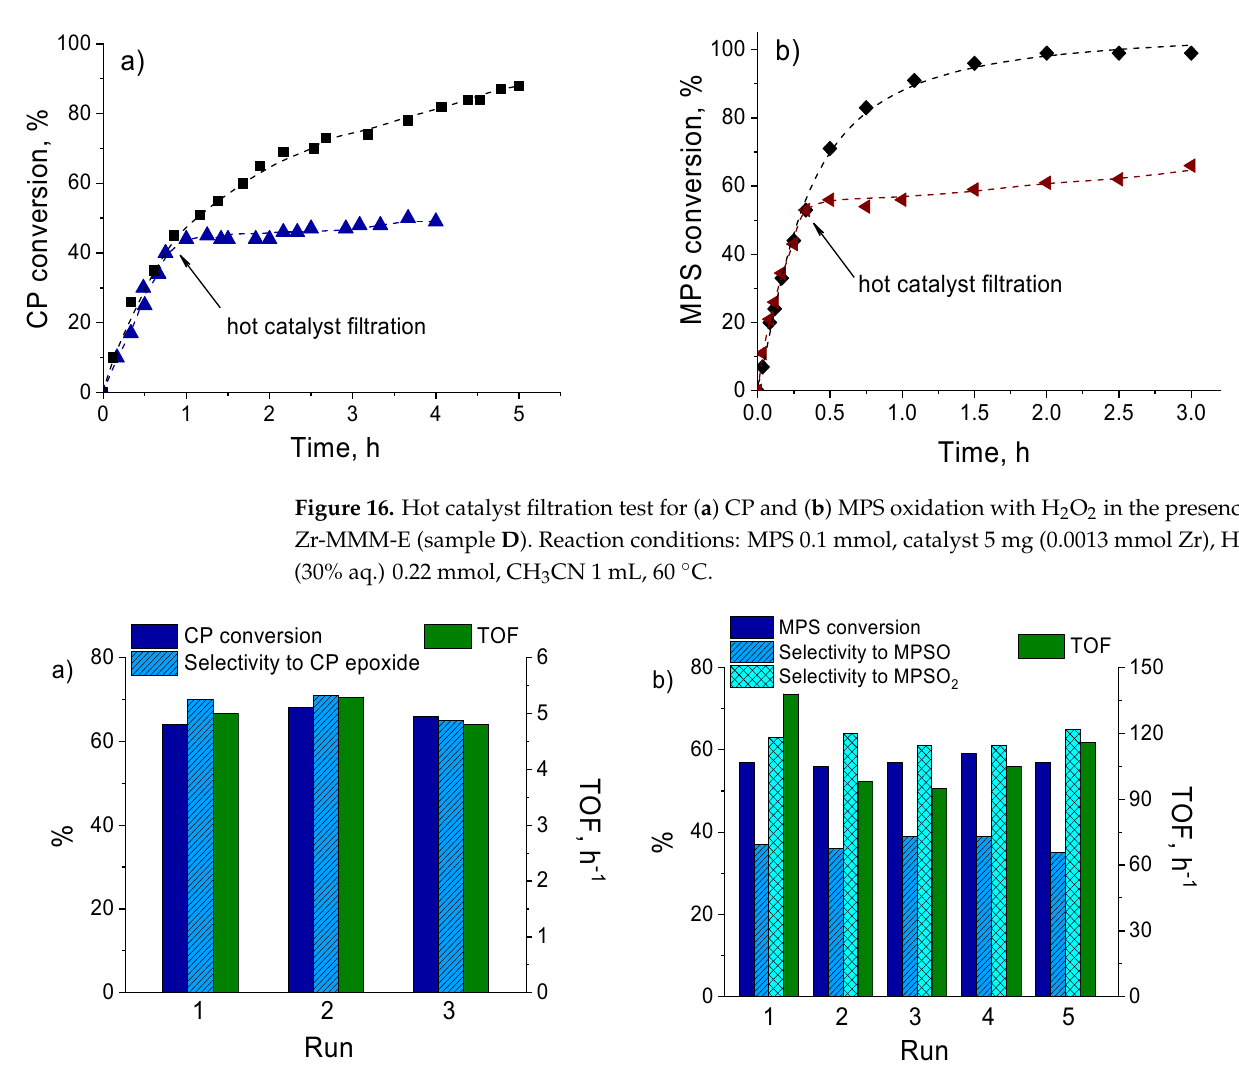
16 of 23 Figure 15. XRD patterns of samples ( a ) A and ( b ) D : initial and after treatment with H 2 O 2 in MeCN. The nature of the catalysis over Zr-MMM-E was verified for both alkene and MPS